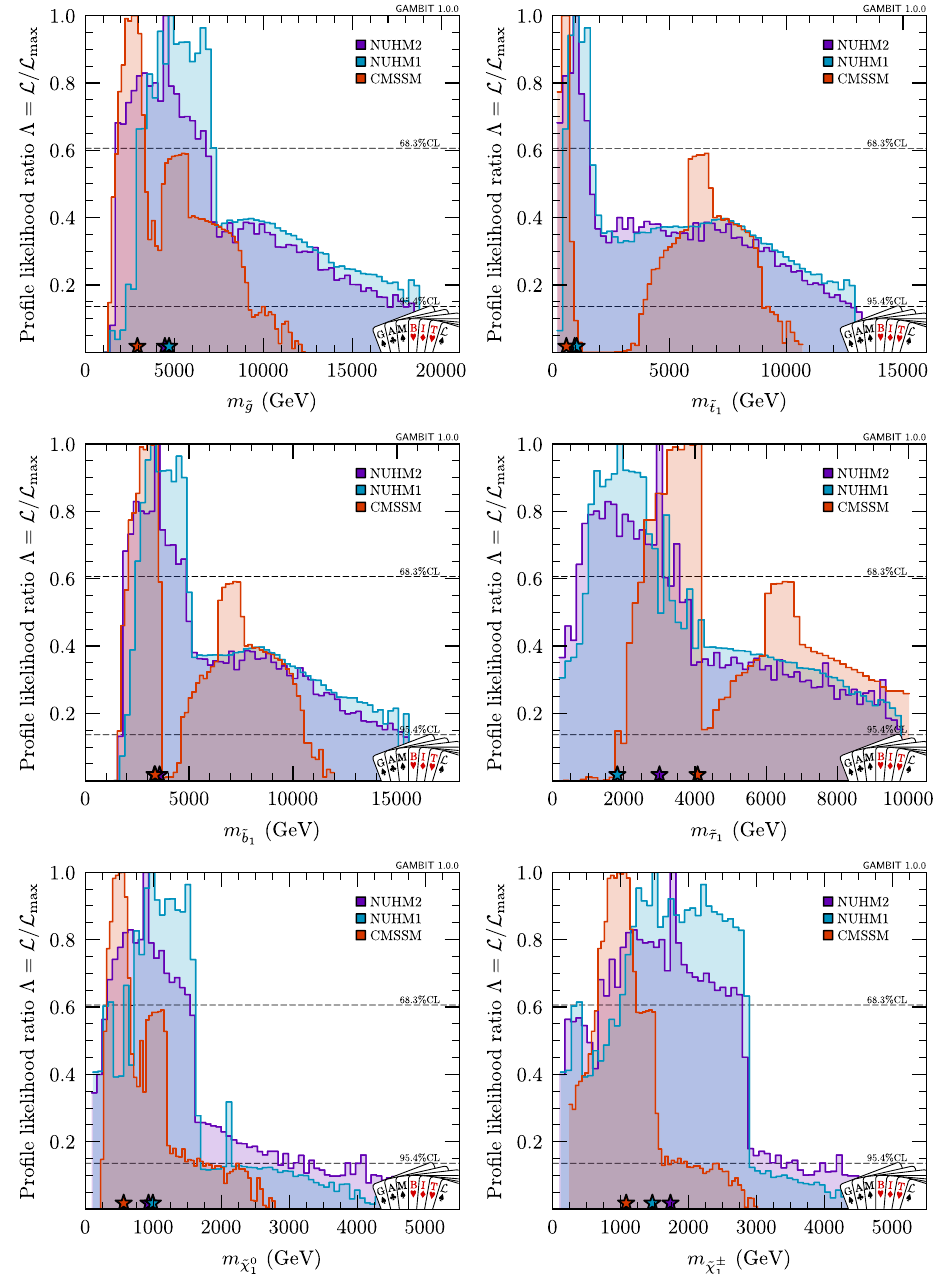
Fig. 12 1D profile likelihoods for the masses of ˜ g , ˜ t 1 , ˜ b 1 , ˜ τ 1 , ˜ χ 0